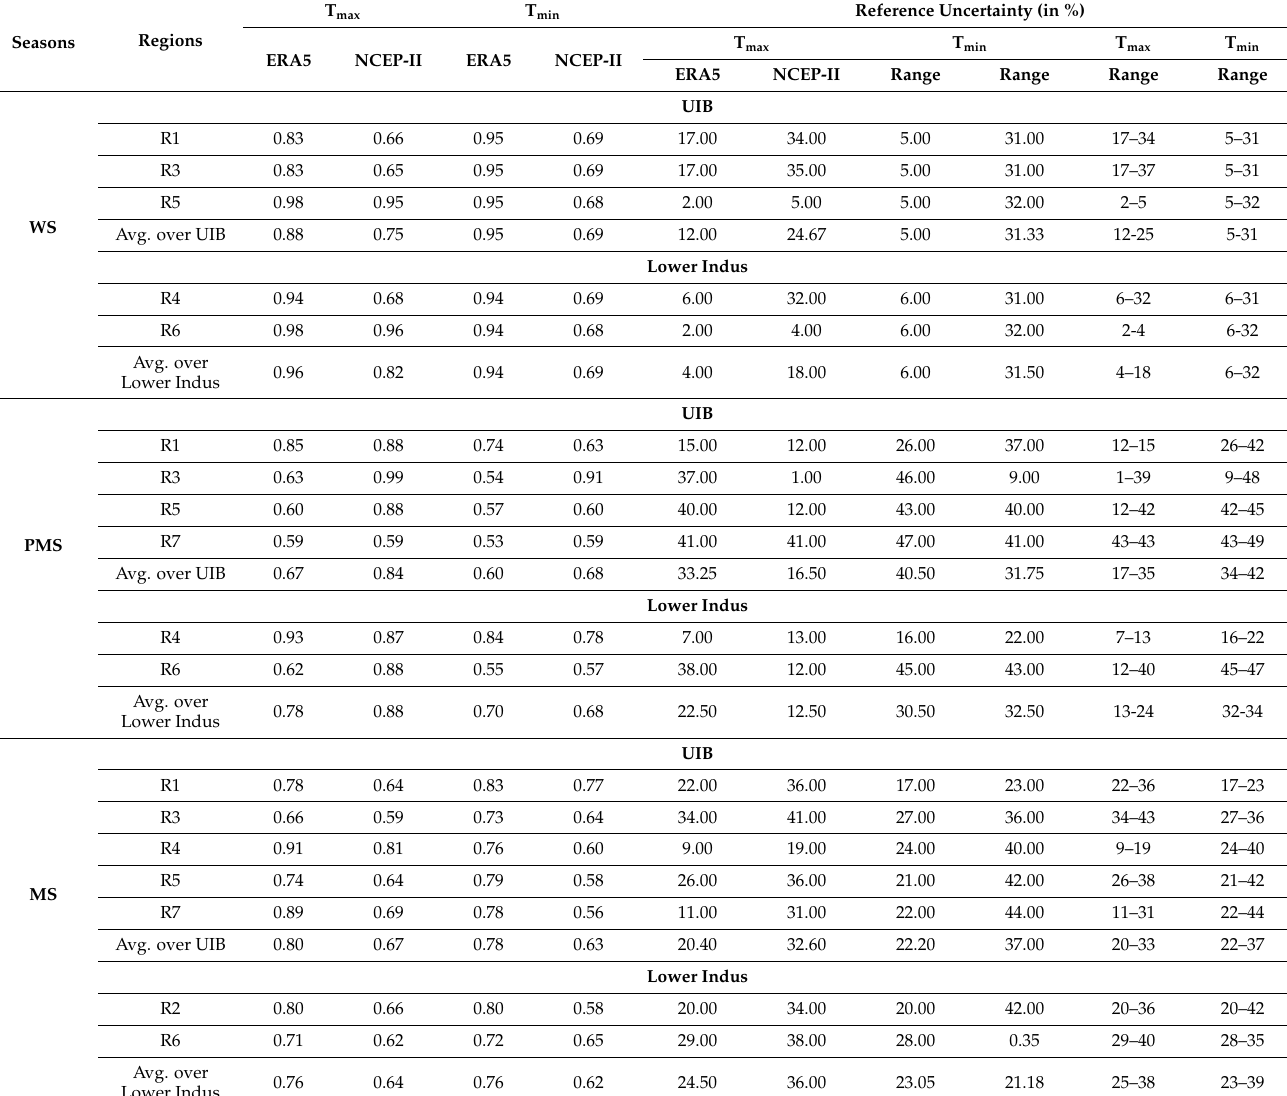
Table 3. Quantification of the reference uncertainty for temperature (T max and T min ) simulations over the study basin using the weighted PS of ERA-Interim predictors. The PS was computed by separately comparing ERA-Interim predictors against the variables of ERA5 and NCEP-NCAR-II reanalysis datasets and shows the strength of predictor correspondence among different datasets. The regions are grouped into the UIB, and Lower Indus scales to assess spatial predictor correspondence between these reanalysis datasets during each season. The last two columns show the range of reference uncertainties in percentage ((1-PS) ×